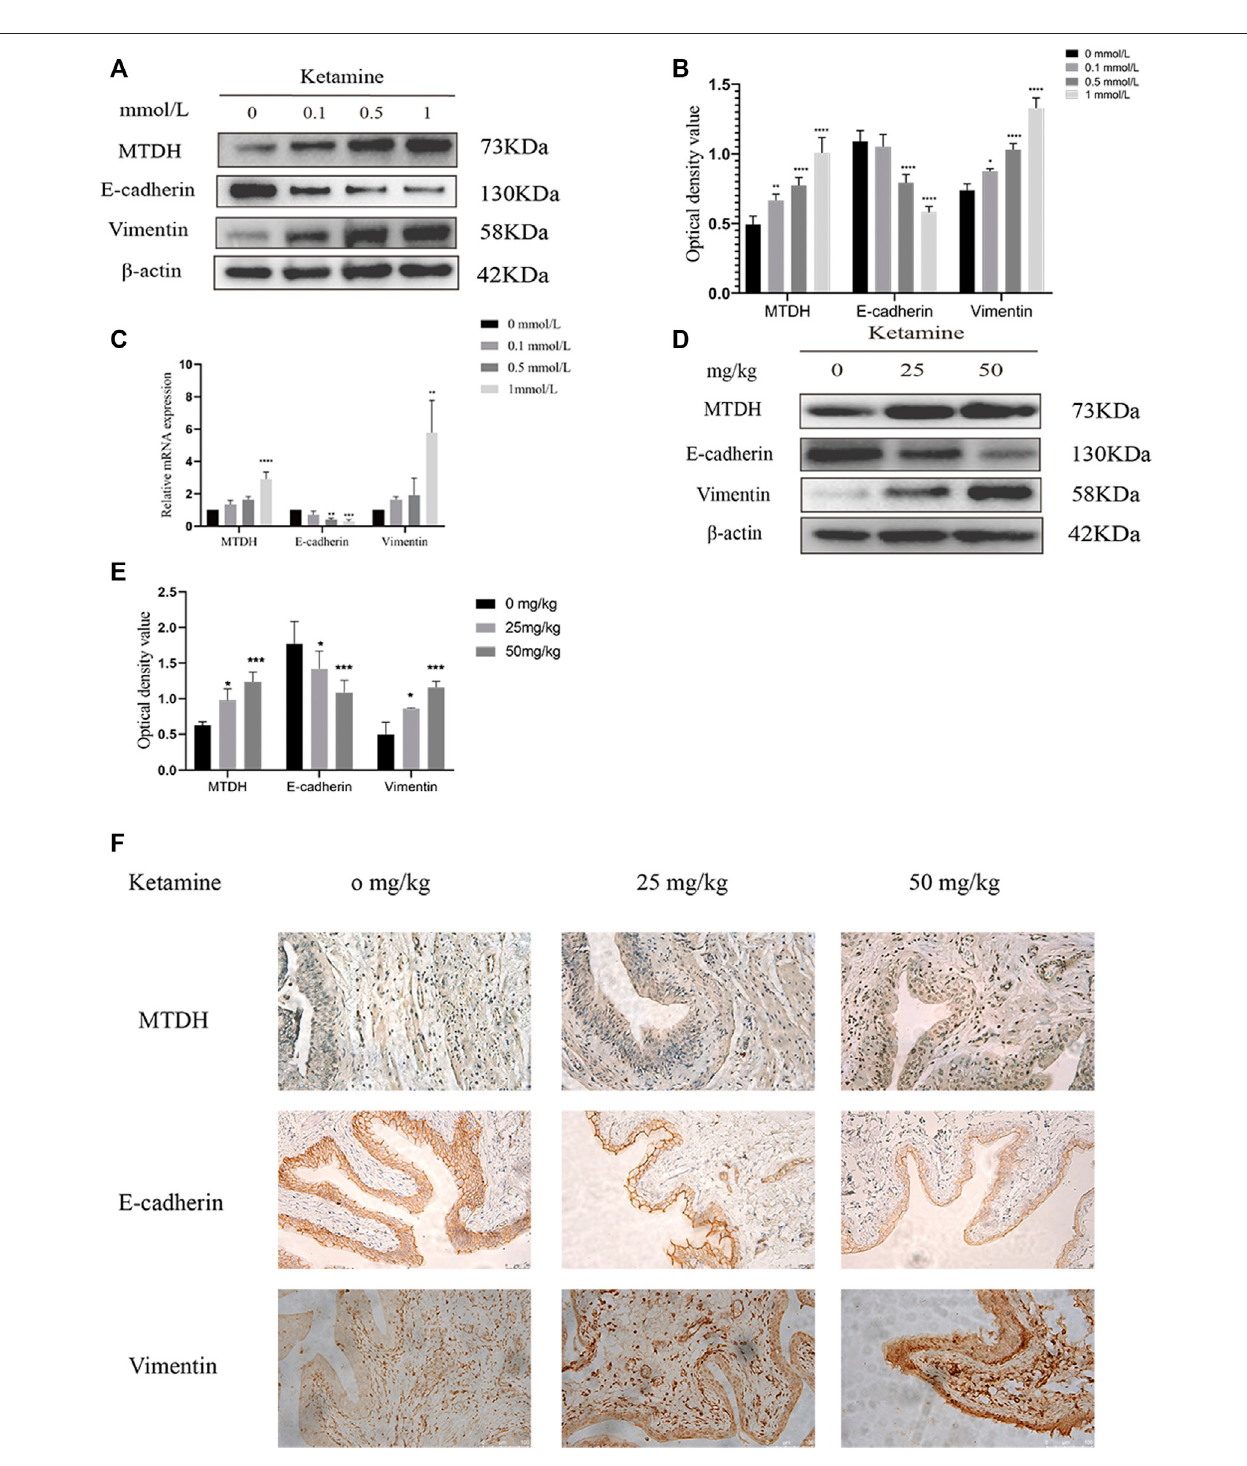
FIGURE3| ExpressionofMTDHandEMTmarkersinSV-HUC-1cellsandratbladderaftertreatmentwithdifferentconcentrationsofketamine. (A) Representative bandsfromWesternblotanalysesofthelevelsoftheMTDH,E-cadherin,vimentin proteininSV-HUC-1cellsafter beingtreatedwithdifferentconcentrationsofketamine (treated for 48 h). (B) Relative levels of the MTDH, E-cadherin, vimentin protein compared to GAPDH in SV-HUC-1 cells. * p < 0.05 compared with 0 mmol/L; ** p < 0.01 compared with 0 mmol/L; **** p < 0.0001 compared with 0 mmol/L. (C) Relative levels of the MTDH, E-cadherin, vimentin mRNA compared to GAPDH. ** p < 0.01 compared with 0 mmol/L, *** P < 0.001 compared with 0 mmol/L, **** p < 0.0001 compared with 0 mmol/L (treated for 48 h). (D) Representative bands from Western blot analyses of the levels of the MTDH, E-cadherin, vimentin protein in rat bladder tissue after being treated with different concentrations of ketamine (treated for 12 w). (E) RelativelevelsoftheMTDH,E-cadherin,vimentin proteincomparedtoGAPDHinratbladdertissue.* p < 0.05compared with0 mg/kg;*** p < 0.0001compared with 0 mg/kg. (F) Representative micrographs of IHC staining for MTDH, E-cadherin, vimentin in rat bladder tissue (treated for 48 h). The scale bar is 50 μ m. N (cid:1) 3.